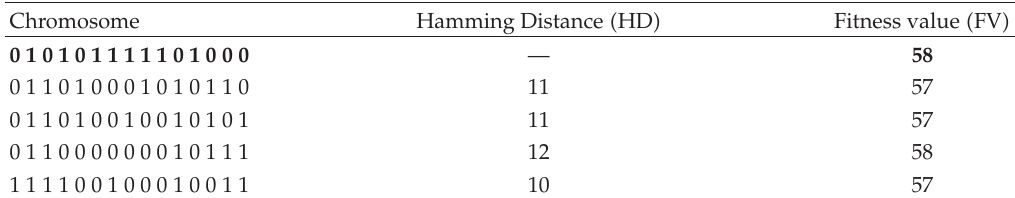
Table 2: A population with low population diversity based on phenotype property (cid:3) FV (cid:4) but with high genetic diversity based on genotype property (cid:3) HD (cid:4) . Chromosome Hamming Distance (cid:3) HD (cid:4) Fitness value (cid:3) FV (cid:4) — 58